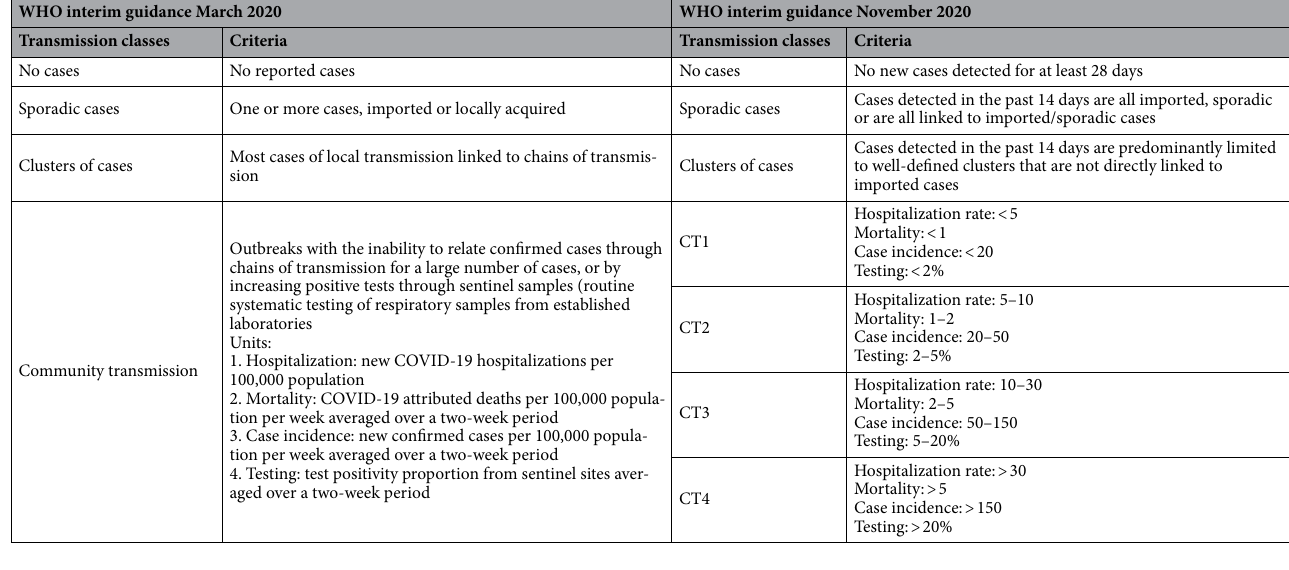
Table 1. Transmission classes of COVID-19 and criteria for each class published by WHO in March 2020 and in November